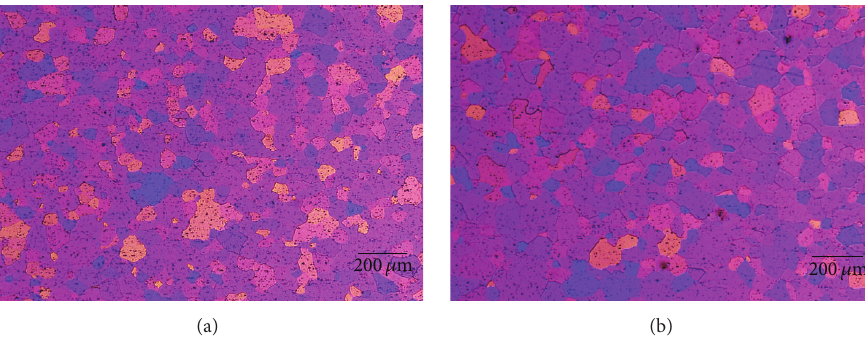
Figure 10: (a) Etched, AR sample. (b) Etched, CTed